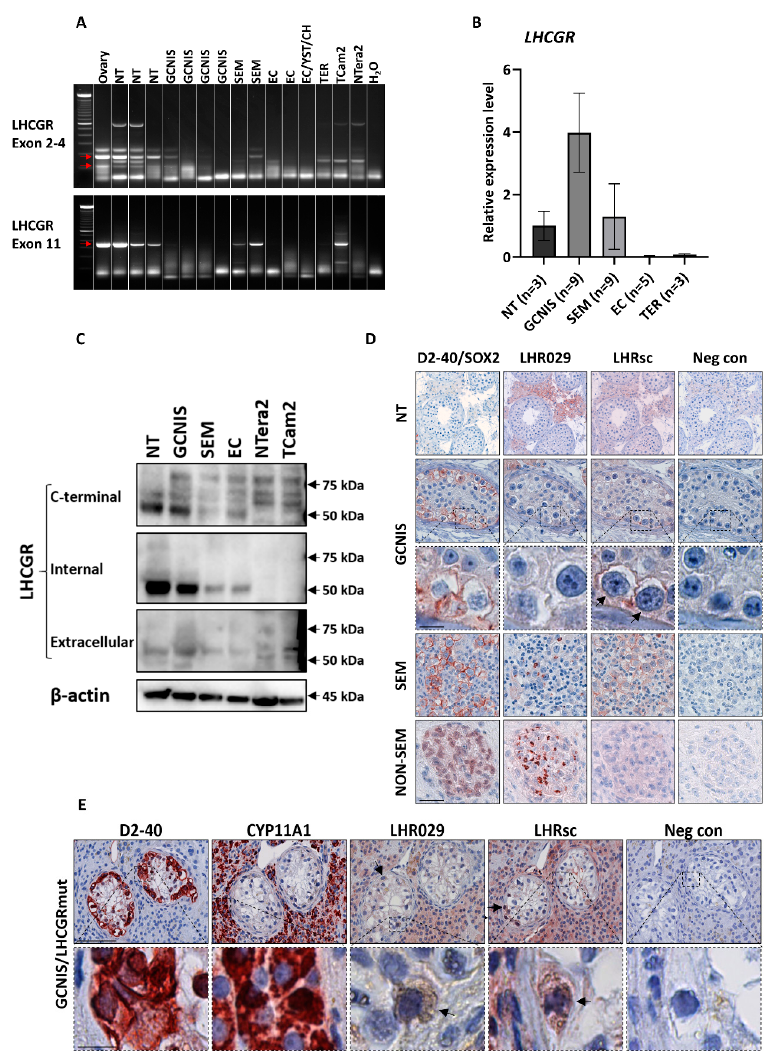
Figure 1. Expression of LHCGR in GCNIS and TGCTs. Expression of LHCGR in human testis cancer tissue and cell lines was analyzed by RT-PCR ( A ), qPCR ( B ), western blot ( C ), and IHC ( D , E ). ( A ) LHCGR mRNA expression analyzed by RT-PCR using two primer sets targeting exon 2-4 or exon 11. ( B ) LHCGR mRNA expression analyzed by qPCR using primer set targeting exon 11 and normalized to RPS20 . ( C ) LHCGR protein expression analyzed by western blot using β -actin as loading control. ( D ) Localization of LHCGR investigated by IHC in TGCT tissue samples. D2-40 was used to mark GCNIS and seminoma cells while SOX2 was used to mark embryonal carcinoma cells in non-seminoma. Arrows indicate expression in GCNIS cells. Scale bar corresponds to 50 µ m for all images except the higher magnification of GCNIS cells, in which the scale bar represents 12.5 µ m for all images. ( E ) Localization of LHCGR in GCNIS tubules of a patient with a constitutively active mutation in LHCGR. D2-40 was used to mark GCNIS cells and CYP11A1 was used to mark Leydig cells. Arrows indicate expression in GCNIS cells. Scale bar in upper panel corresponds to 50 µ m (all images), while scale bar in lower panel corresponds to 12.5 µ m (all images). Abbreviations: CH, choriocarcinoma; EC, embryonal carcinoma; GCNIS, germ cell neoplasia in situ; NT, normal testis; SEM, seminoma; TER, teratoma; YST, yolk sac